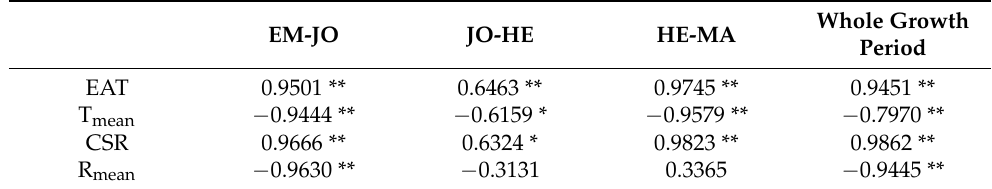
Table 9. Correlation between temperature and radiation on dry matter of spring wheat in different periods at Jianhu County. Whole Growth EM-JO JO-HE HE-MA Period EAT 0.9762 ** 0.8576 ** 0.9712 ** 0.9063 ** T mean − 0.7918 ** − 0.7183 ** − 0.9288 ** − 0.7363 ** CSR 0.9156 ** 0.8644 ** 0.8702 ** 0.9899 ** R mean − 0.8977 ** 0.5891 * − 0.7970 ** − 0.9390